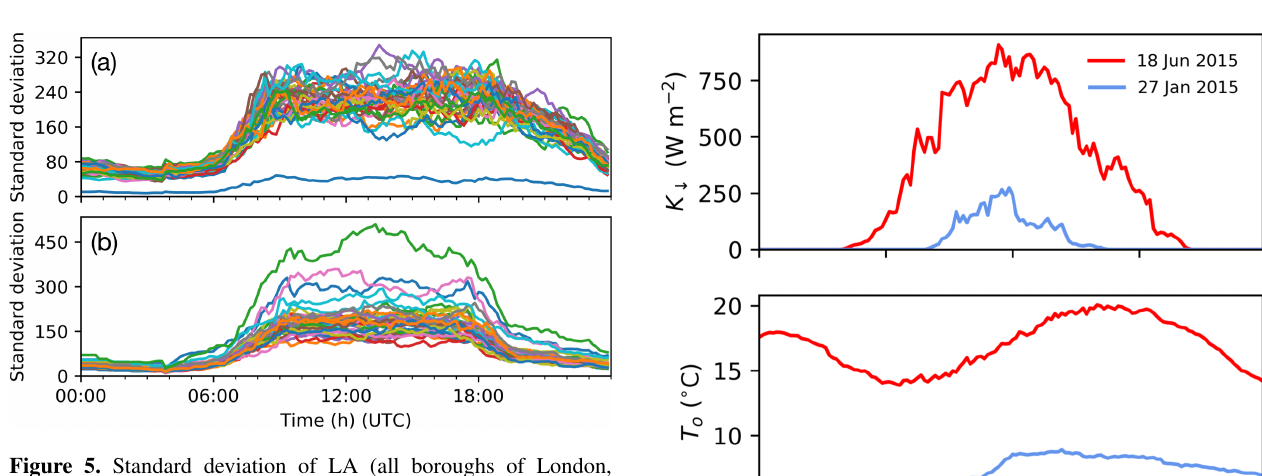
Figure 4. Present occupancy levels (R3, Table 6) in three a N group living in the area: 0 infants, 2 children, 0 teenagers, 61 adults, 228 seniors); (b) a working 9 seniors); (c) a young D